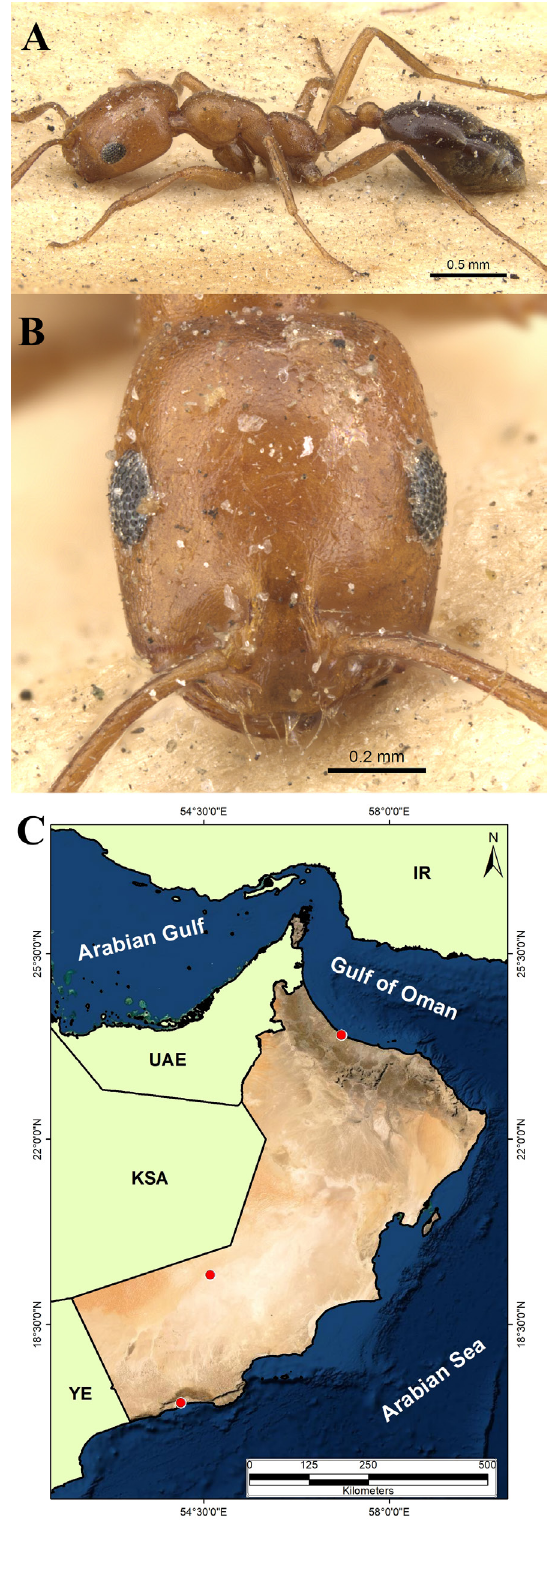
Fig. 43. Monomorium venustum (Smith, 1858), syntype, worker (CASENT0902221, AntWeb.org (Will Ericson)). A . Body in profile. B . Head in full-face view. C . Distribution